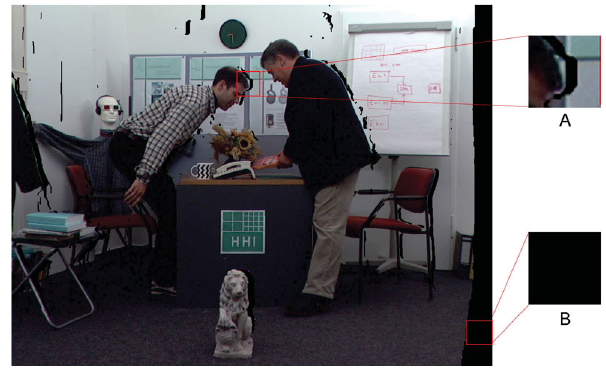
Fig. 3 Visual appearance of image patches containing geometric distortions. Patch A has partial holes, while patch B is dominated by holes. Compared to patch A, patch B is generally perceived as a higher quality image patch, if knowledge of geometric distortions in the whole image is not